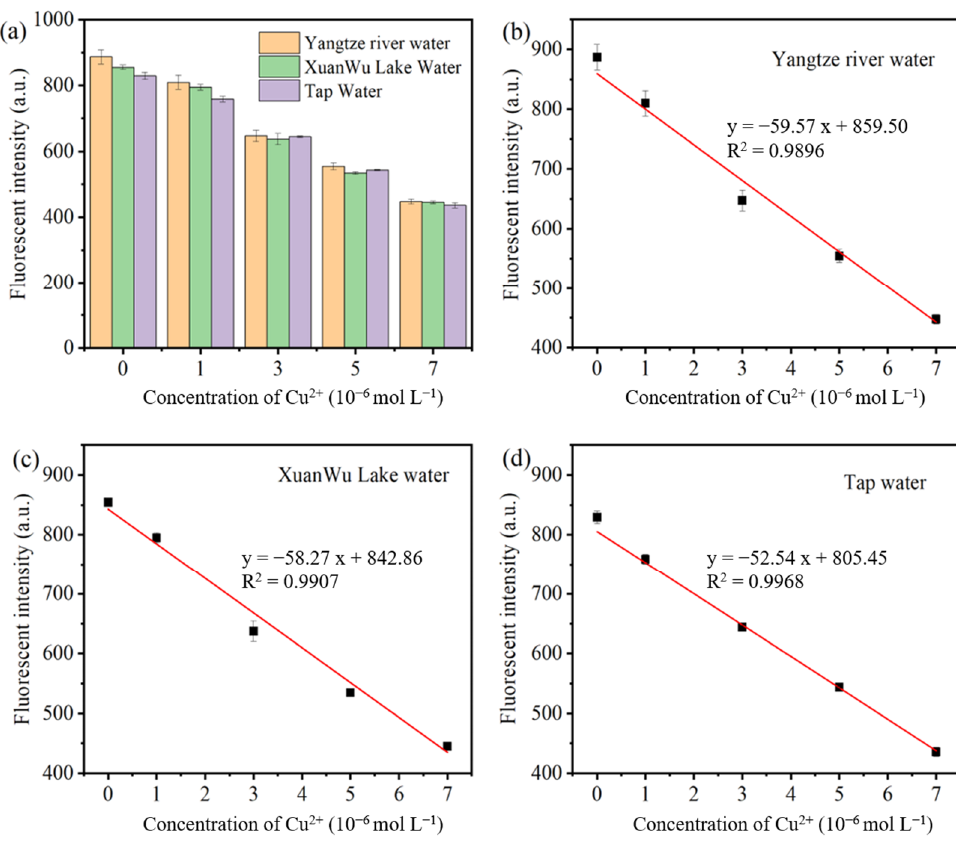
Figure 13. ( a ) Fluorescence intensity of CMC−GE−AQ at 579 nm for different concentrations of Cu 2+ ; a linear relationship between fluorescence intensity at 579 nm and Cu 2+ concentration in ( b ) Yangtze river water, ( c ) Xuanwu lake water and ( d ) tap water. (CMC−GE−AQ: 1.5 × 10 −4 g mL −1 ; solvents: DMF/real water samples solution ( v / v = 8/2, pH = 7); Cu 2+ : 0, 1, 3, 5 and 7 × 10 −6 mol L −1 ; excitation wavelength: 425 nm; excitation slit: 5 nm).